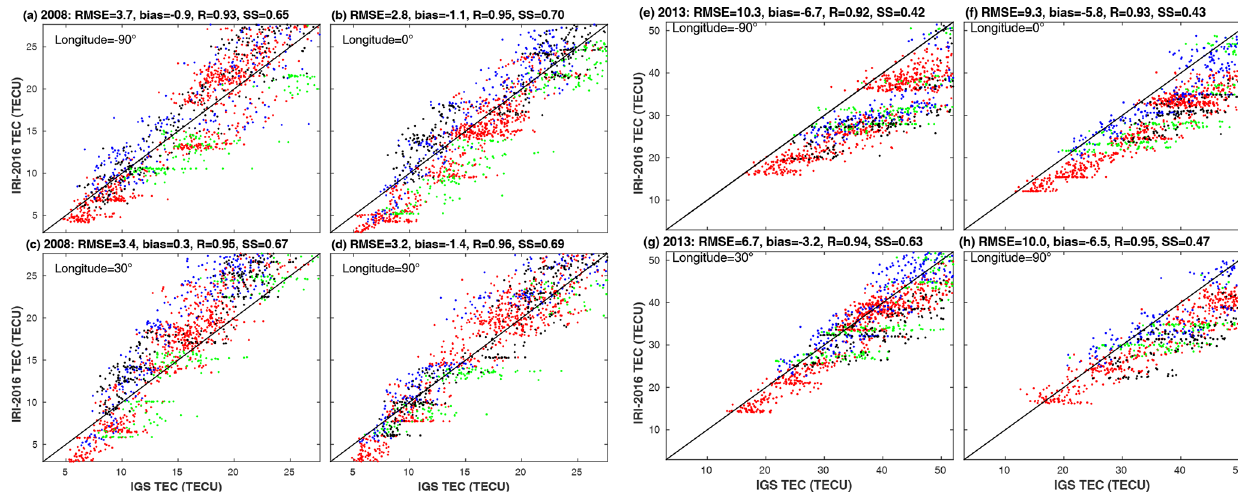
Figure 6. The same as Fig. 5 but for afternoon observations and